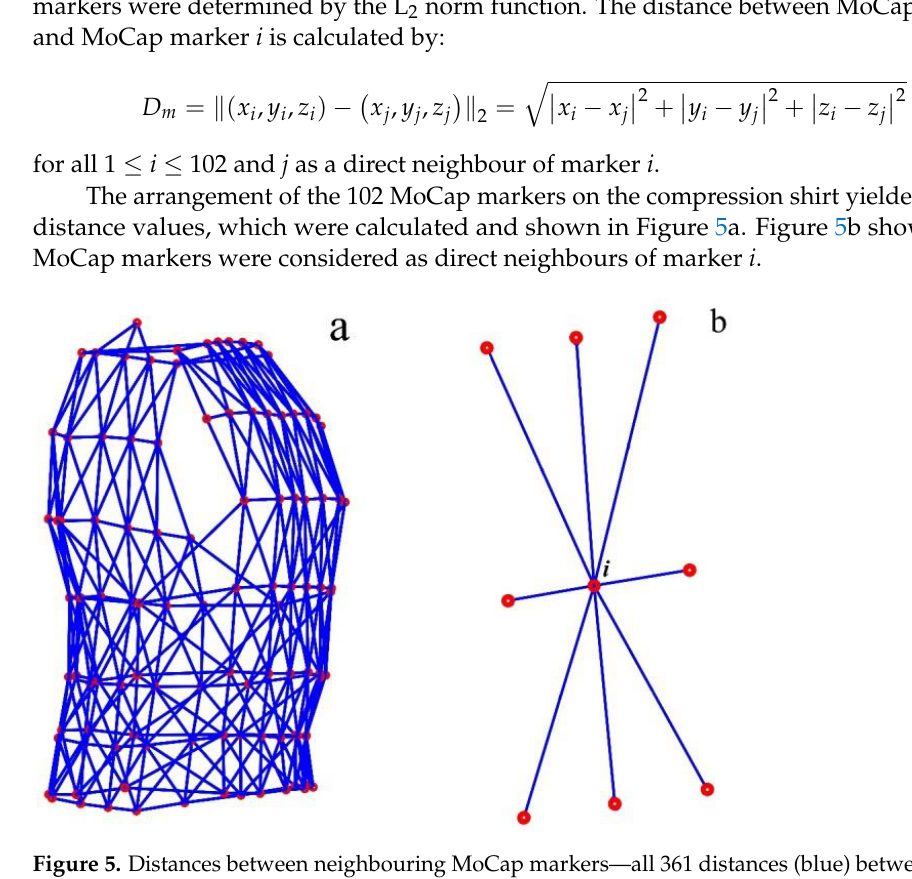
Figure 5. Distances between neighbouring MoCap markers—all 361 distances (blue) between MoCap markers (red), which were determined ( a ). The eight neighbouring MoCap markers of marker i in the middle of the illustrated marker-set ( b ).